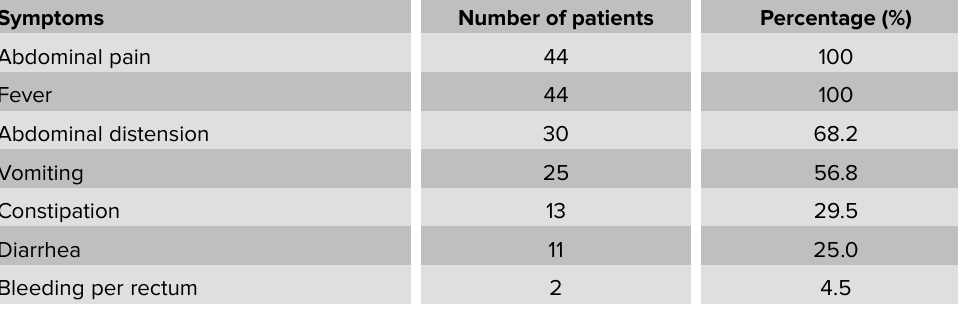
TABLE 2: Symptomatology of the